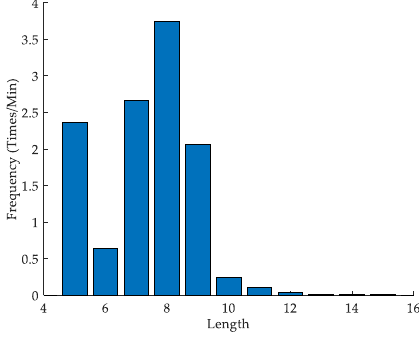
Figure 3. Bar chart of length-frequency distribution for alarm messages.